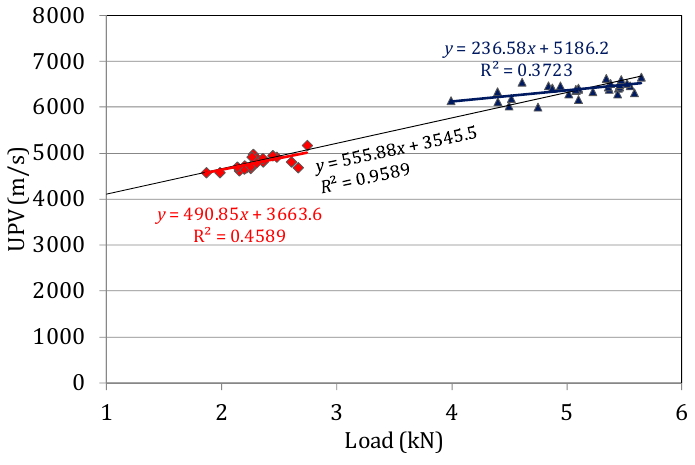
Figure 6. Correlation between pulse velocity and maximum load for the marble specimens.